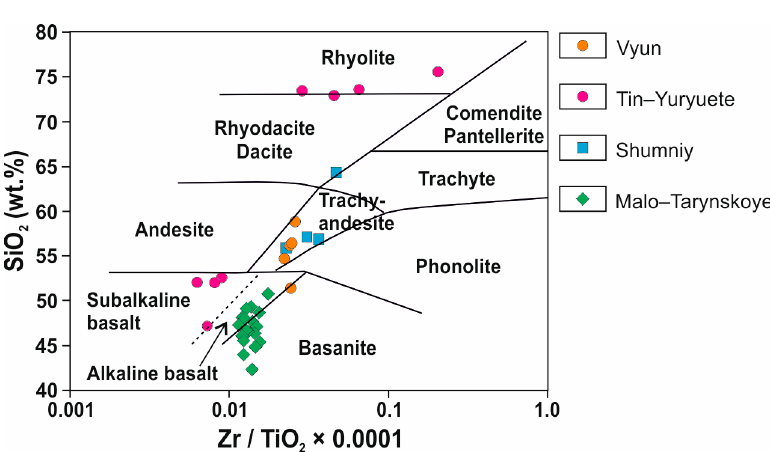
Figure 5. SiO 2 versus Zr/TiO 2 × 0.0001 diagram from [61] for the studied igneous rocks. Samples from the Tin–Yuryuete site included samples from [18]. Samples from the Malo–Tarynskoye deposit included samples from [12].